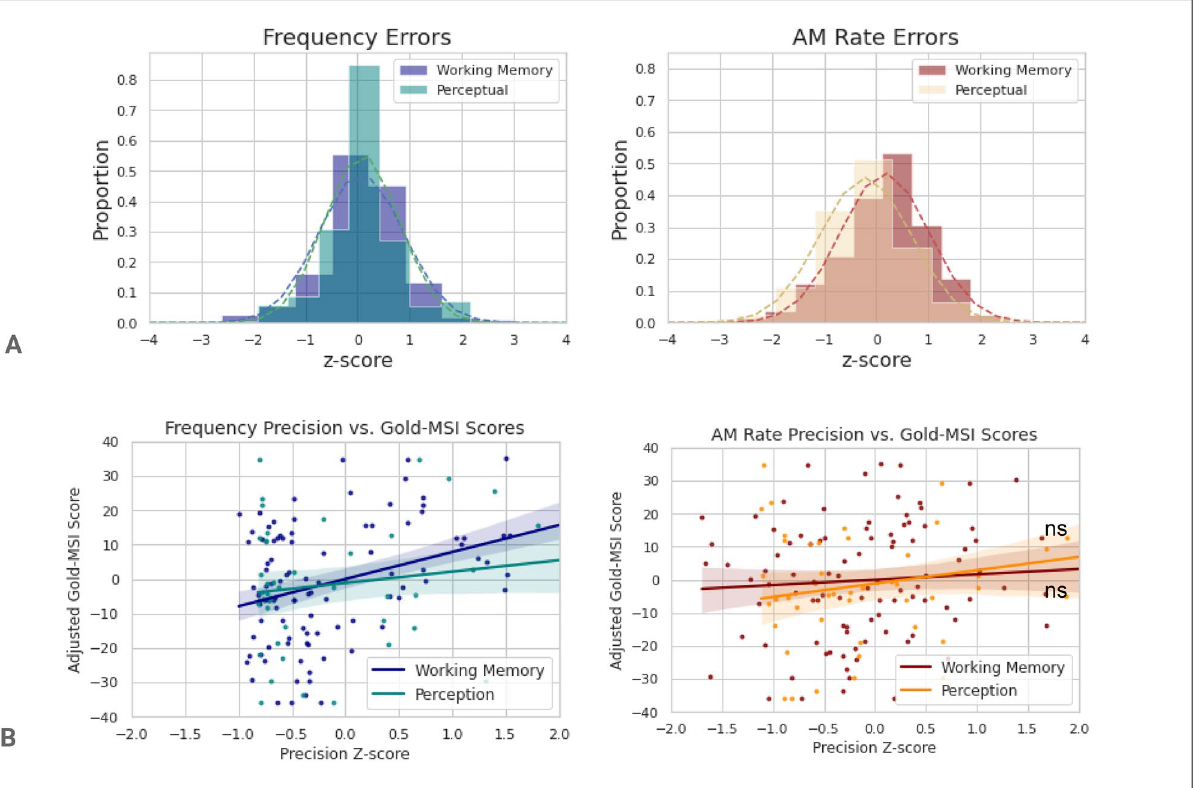
Figure 4. ( A ) The distributions for all auditory domains of working memory and perception tested in Experiment 2 are shown (top row). All participants’ performances were Gaussian but the distribution of perceptual errors has a smaller degree of variability than working memory errors. ( B ) Scatter plots showing overall auditory precision for frequency (left) and amplitude modulation rate (middle row) as a function of scores on the Gold-MSI questionnaire. For tone frequency, precision of working memory (represented by the dark blue line) but not perception (represented by the teal coloured line) was significantly correlated with Gold- MSI scores. For AM rate, neither perceptual nor working memory precision was significantly correlated with Gold-MSI scores. ns not